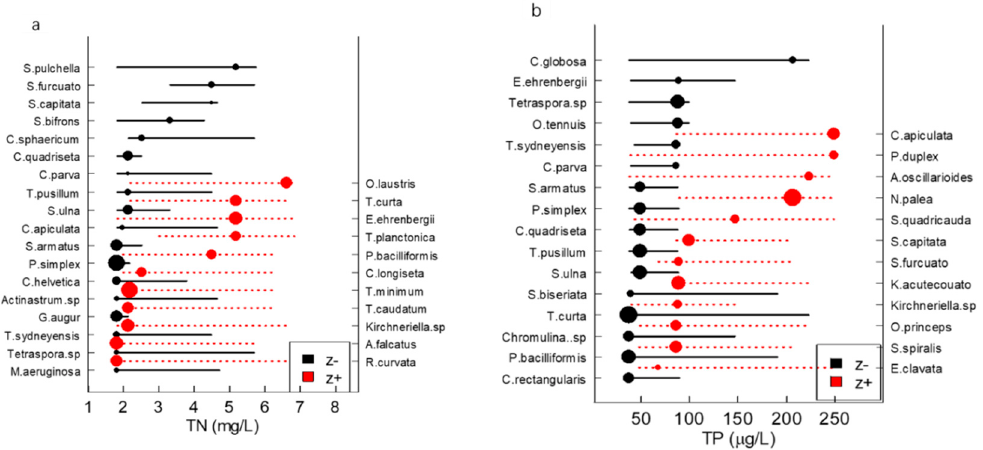
Figure 5. The TITAN results showing significant indicator taxa of TN and TP ( a , b ). The circles show taxa change points, which were sized according to the magnitudes of response. (a) title; (b) title.